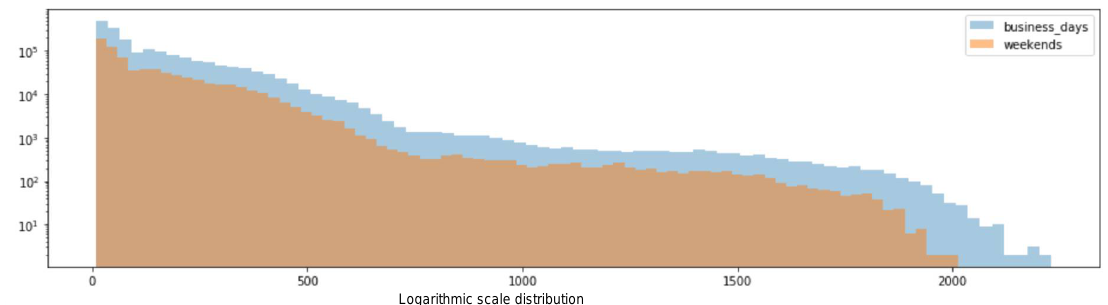
Figure 3. The histogram graphics in logarithmic scale shows the distribution of the number of mobile phones in all the cells of the largest one of the two grids. In particular the distribution in light blue regards the observations during business days while the brown one is about the observations seen during the